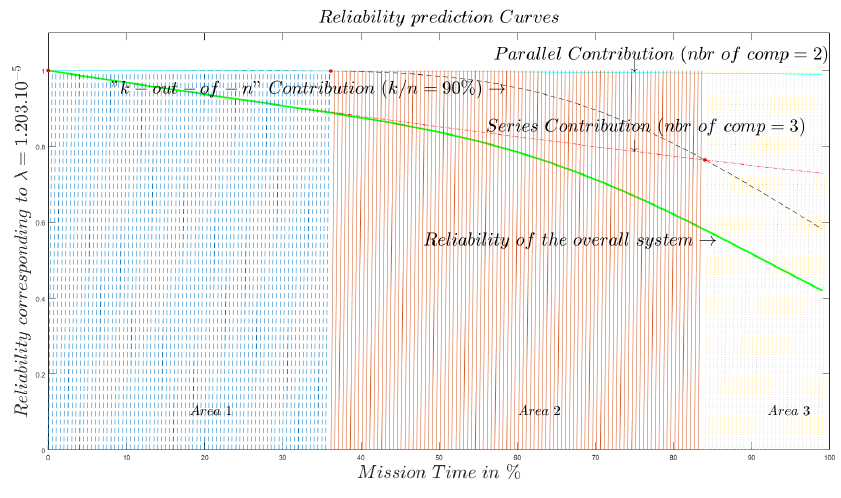
Figure 17. Reliability behavior of an End-to-End IoT system with k / n =